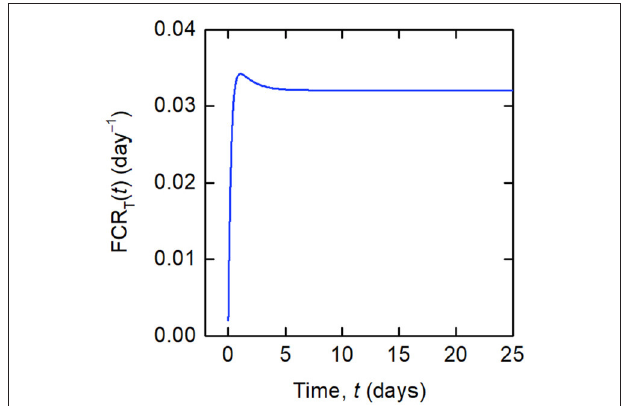
FIGURE 4 | Simulation of FCR T ( t ) given by Equations (12) and (8), for the parameter values in Table 1 and dose D = 0.01 µ mol.